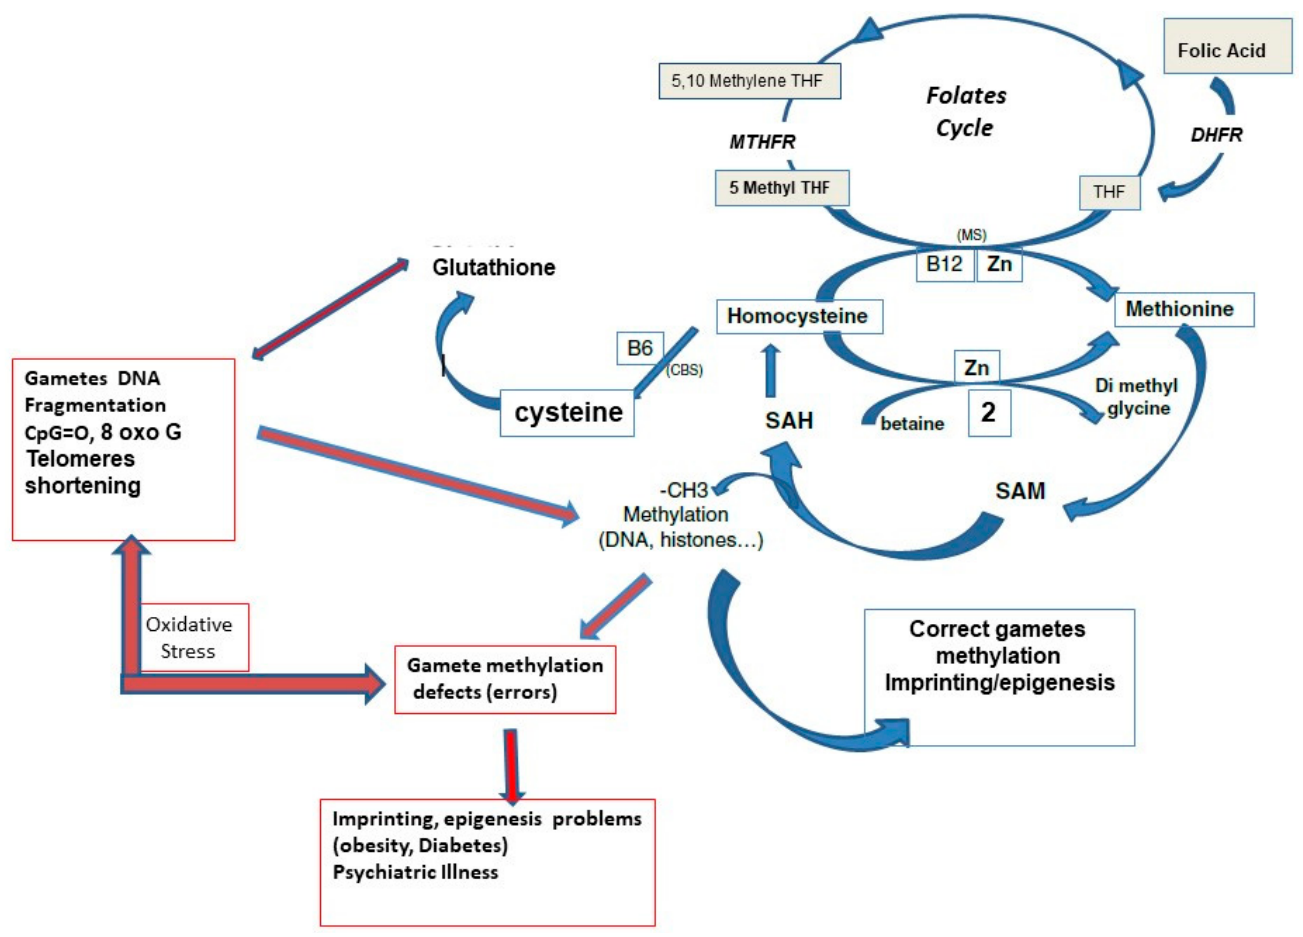
Figure 1. Interrelations between the one carbon cycle (methionine cycle) and the folates cycle. B6: vitamin B6, B12: vitamin B12, DHFR: dihydrofolate reductase, CBS, cystathionine beta synthase pathway, MS: methionine synthase, MTHFR: methylene tetrahydrofolate reductase, THF: tetrahydrofolate. SAH: S adenosylhomocysteine, SAM: S adenosyl methionine, CpG: cytosine phos- phate guanine, Zn: zinc.